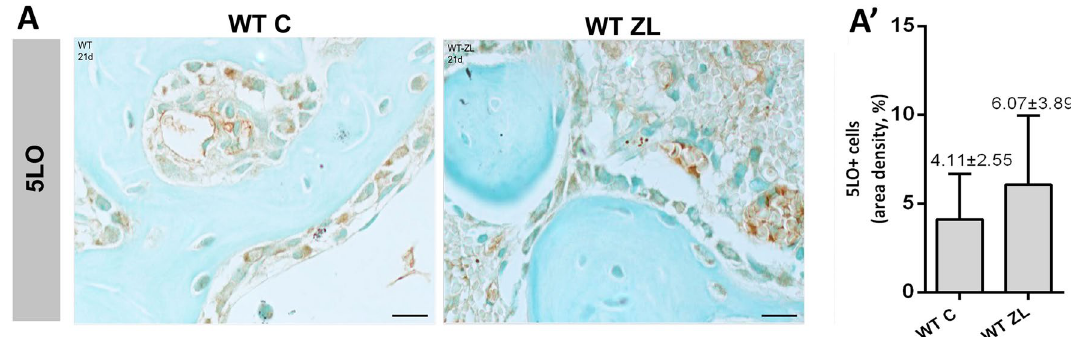
Figure 5. Immunolabeling and quantification of 5LO + cells at 21 days post tooth extraction in WT C vs. WT ZL. Aged 129 Sv WT female mice received IP injections of 0.9% saline solution ( C ) or 250 μg/Kg (ZL groups) once a week, and upper right incisor were extracted at 4 week of each treatment. ( A ) Representative transversal sections from the central area of alveolar sockets stained for 5LO + cells in WT C and WT ZL group. ( A’ ) Quantitative and comparative analysis of detached 5LO + cells in WT C vs. Scale bar 30 µm. WT ZL mice at 21 days post-extraction. Results are presented as the means (± SD) of area density (%). Symbol * indicates